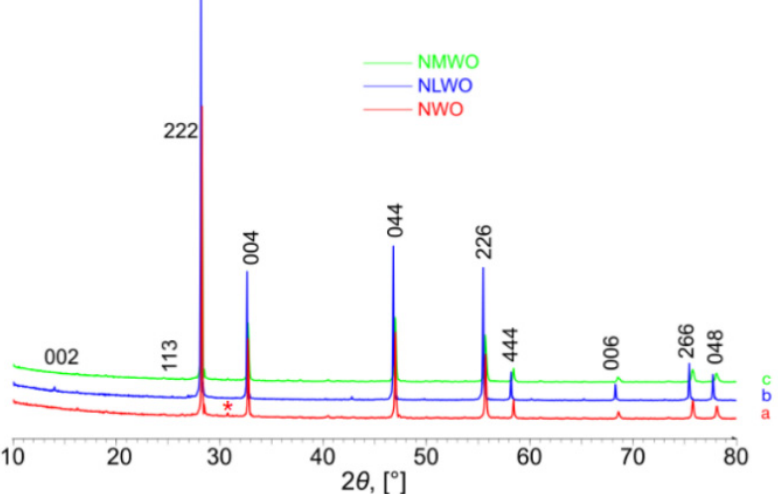
Figure 1. XRD patterns of samples synthesized by mechanical activation and sintered using electron beams at 1100 °C: ( a ) NWO, ( b ) NLWO, ( c ) NWMO. *—Nd 2 O 3 [PDF 043-1023].